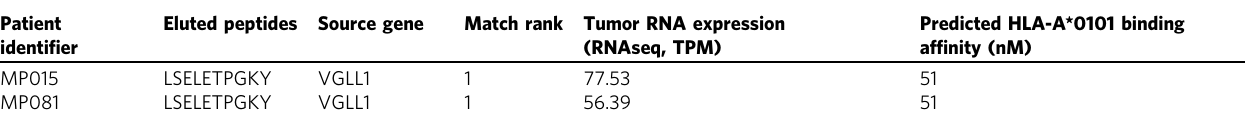
Table 1 VGLL1-derived peptide eluted from two HLA-A*0101 + PDAC patient tumor organoids. Patient Eluted peptides Source gene Match rank Tumor RNA expression identi fi er